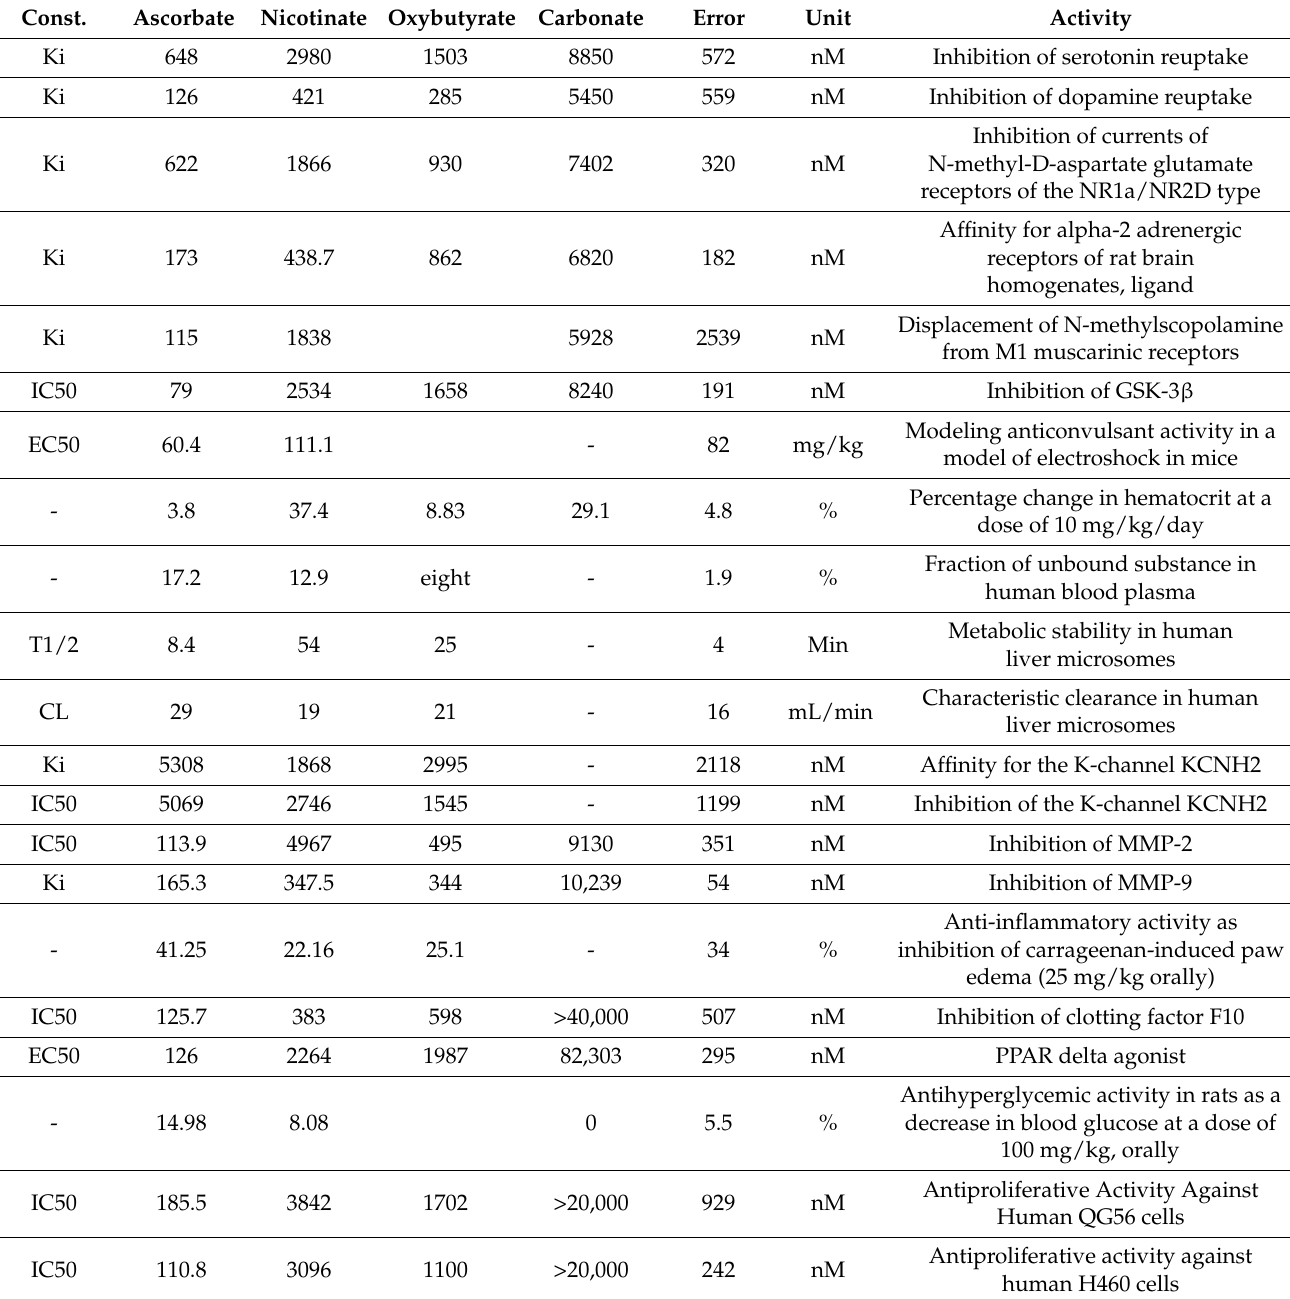
Table 1. Results of chemoreactomic analysis of the lithium salts. “Const.”, The common name for the type of investigated pharmacological constant (“Ki”, “IC50”, etc.); “Error”—the error of the estimated biological constant; “Unit”, units of